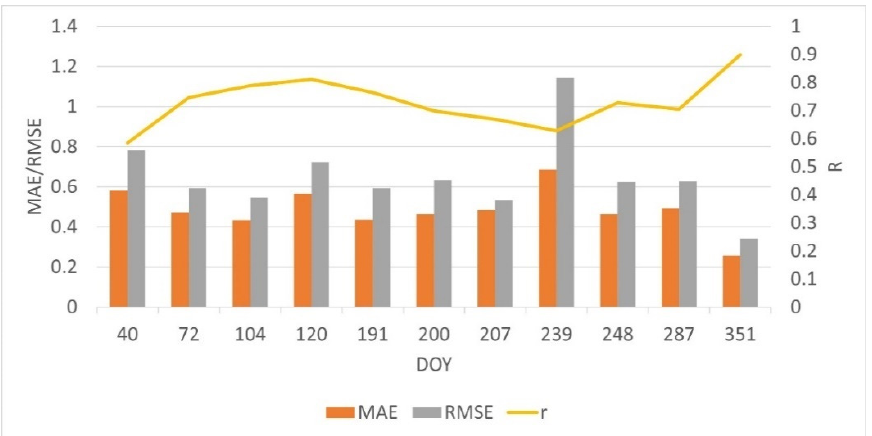
Figure 13. Bar graph of LAI predictions statistics (MAE, RMSE, and r ) at the CCN area. Table 10. Quantitative validation of LAI for all input days at the CCN area.